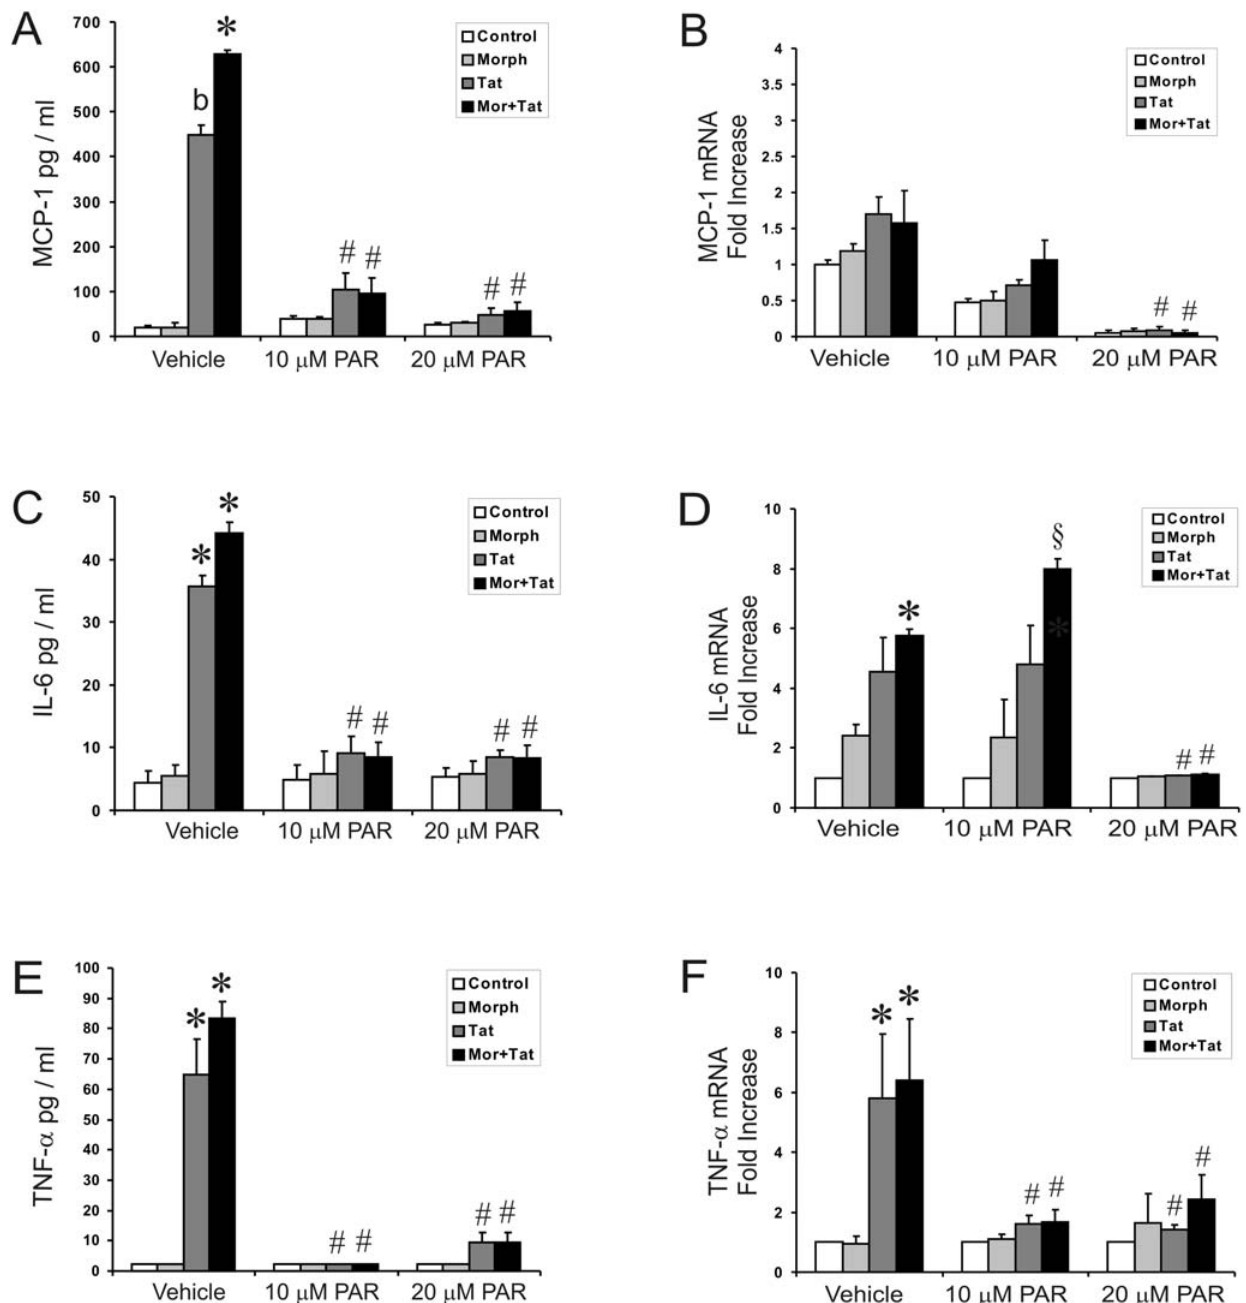
Figure 1. Effects of parthenolide on Tat 6 morphine-induced increases in MCP-1, IL-6 and TNF- a protein and mRNA levels. Astrocytes were pretreated with 10 or 20 m M of the NF- k B inhibitor, parthenolide (PAR), for 15–20 min followed by incubation with HIV-Tat 6 morphine (Morph or MOR) for 12 h (A,C,E) or 24 h (B,D,F). Parthenolide exposure inhibited Tat 6 morphine-induced increases in the release of MCP-1, IL-6, and TNF- a by ELISA at 12 h (A,C,E). Parthenolide exposure (20 m M) caused a significant and sustained reduction in Tat-induced increases in MCP-1, IL-6, and TNF- a mRNA levels at 24 h—that was largely unaffected by coadministering morphine (B,D,F). Values are given as the mean 6 SEM and representative of at least 3–5 independent experiments (* P , 0.05 vs. vehicle-treated controls; b P , 0.05 vs. controls or Tat 6 morphine treatment without PAR; # P , 0.05 vs. Tat 6 morphine treatment without PAR; 1 P , 0.05, vs. Tat + morphine-treated cells exposed to vehicle or 20 m M PAR).